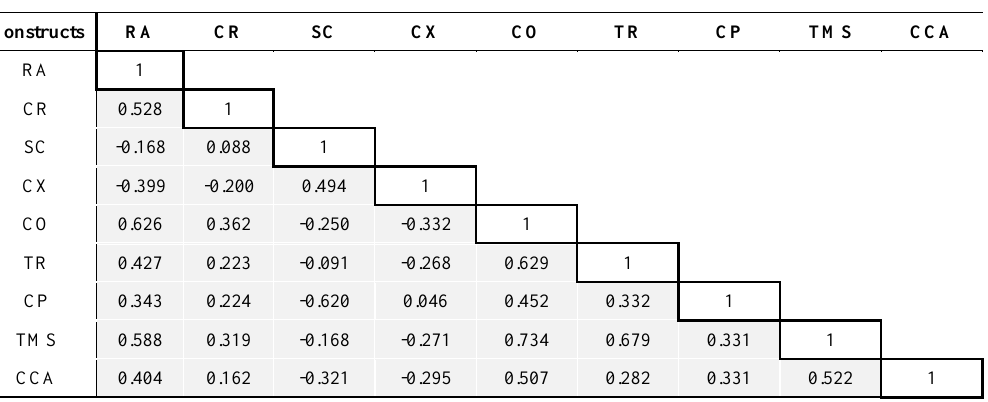
Table 3. Correlation